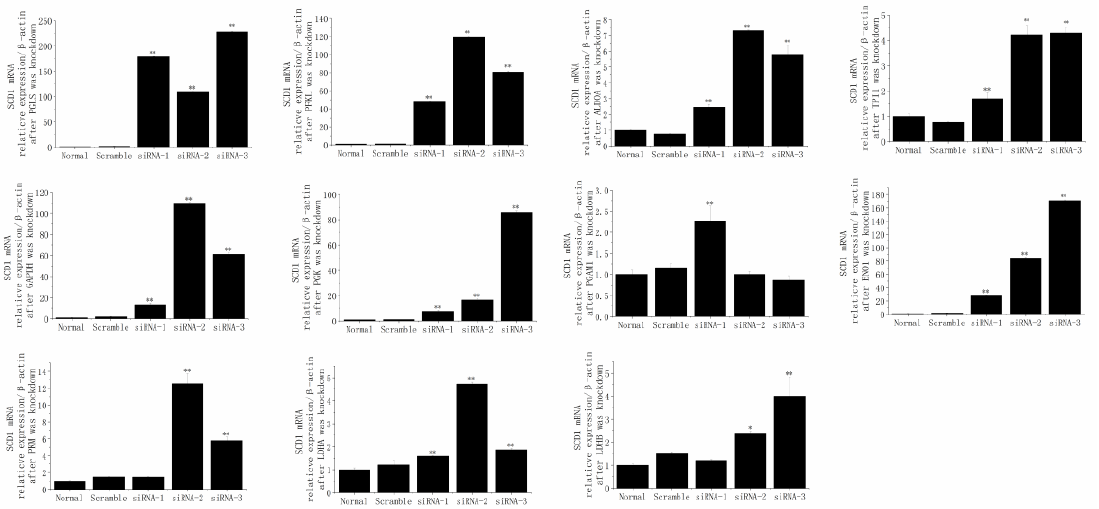
Figure 9. After individual PGLS, PFKL, ALDOA, TPI1, GAPDH, PGK1, PGAM1, ENO1, PKM, LDHA, and LDHB knockdown, the mRNA relative expression levels of SCD1 (stearoyl CoA desaturase 1) were altered in MAC-T cells. * p < 0.05, ** p < 0.01.